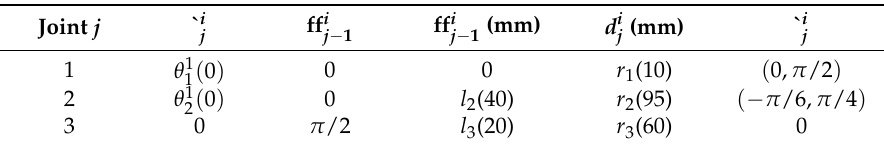
Table 1. The Denavit-Hartenberg (D-H) parameters of the left